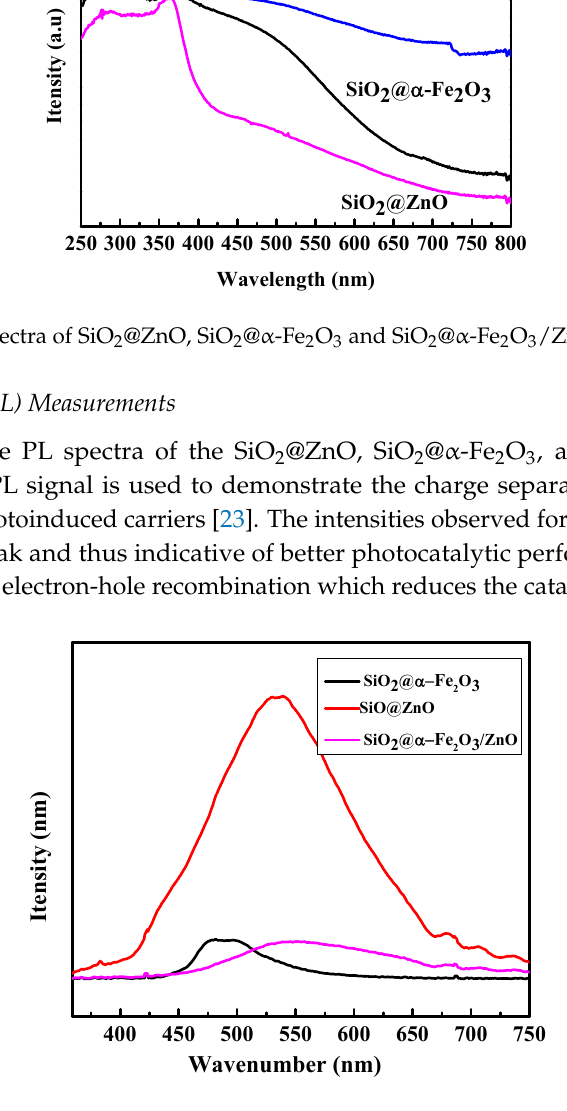
Figure 5. Photoluminescence (PL) spectra of SiO 2 @ZnO, SiO 2 @α-Fe 2 O 3 and SiO 2 @α-Fe 2 O 3 /ZnO.